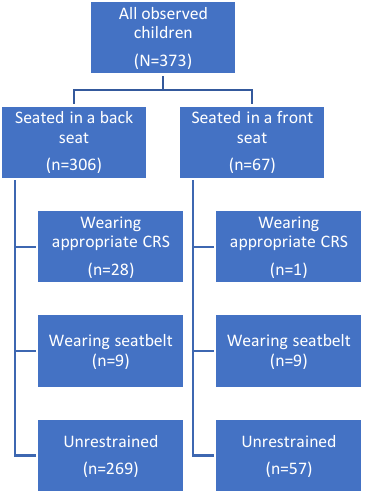
Figure 1. Numbers of children observed to be restrained and unrestrained in the front and back seats.